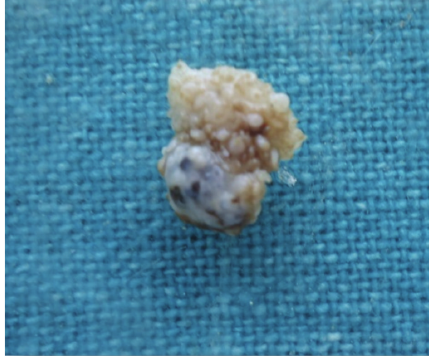
Figure 2: Excised specimen.